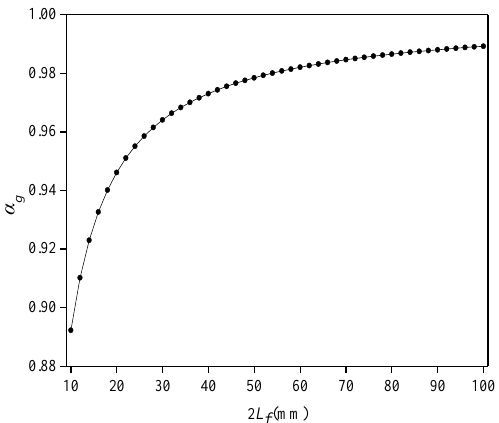
Figure 10. Relationship between length of cemented layer and average strain-transfer coefficient in grooved-bonded model.